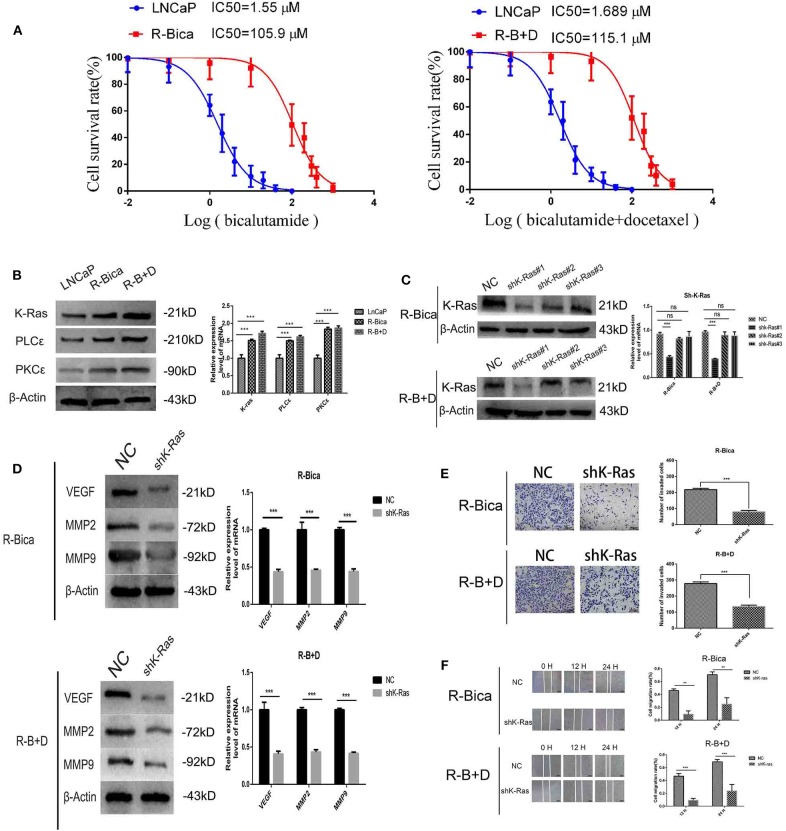
K-Ras, PLCε, and PKCε expression in LNCaP and CRPC cell lines and silencing K-Ras can suppress metastasis of CRPC cells. (A) IC50 was analyzed by cell counting kit-8 (CCK-8), and LNCaP and R-Bica cells were incubated with increasing concentrations of bicalutamide for 48 h; LNCaP and R-B+D cells were incubated with increasing concentrations of bicalutamide and docetaxel for 48 h. (B) The mRNA and protein levels of K-Ras, PLCε, and PKCε in LNCaP, R-Bica, and R-B+D cells were analyzed by Western blot analysis and qPCR. (C) CRPC cells were infected with lentiviral sh-K-Ras; Western blotting and qPCR detected the expression of K-Ras. (D) The expression of VEGF, MMP2, and MMP9 in CRPC cells was examined by Western blot and qPCR analysis. (E,F) The invasive and migratory capacities of CRPC cells were detected by Transwell and wound-healing assays. R-Bica cells, bicalutamide-resistant LNCap cells; R-E+D cells, sequential dual-resistant LNCap cells (bicalutamide-resistant and docetaxel-resistant LNCaP cells); sh, small hairpin; NC, negative control; shK-Ras, K-Ras knockdown. Data were presented as the means ± SD. **P < 0.01, ***P < 0.001; ns, no statistical significance.